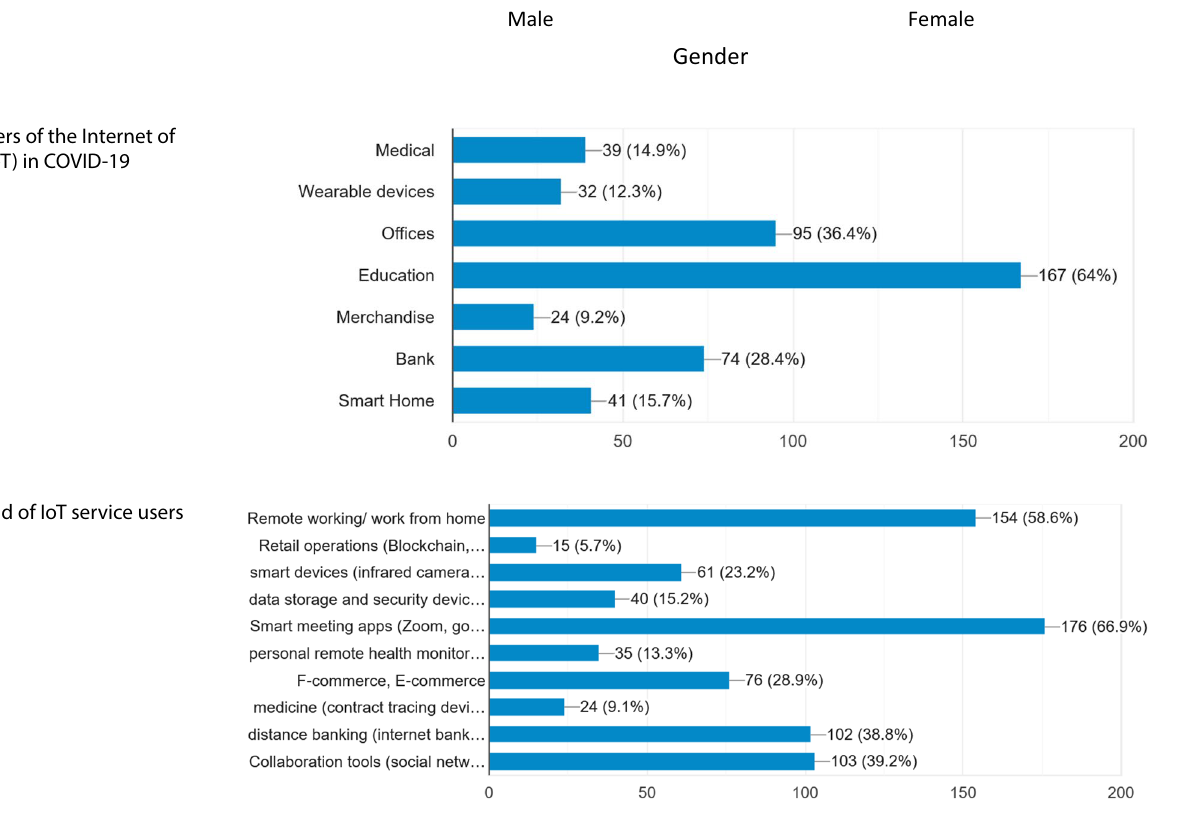
Fig. 7 Users of the Internet of Things (IoT) in COVID-19